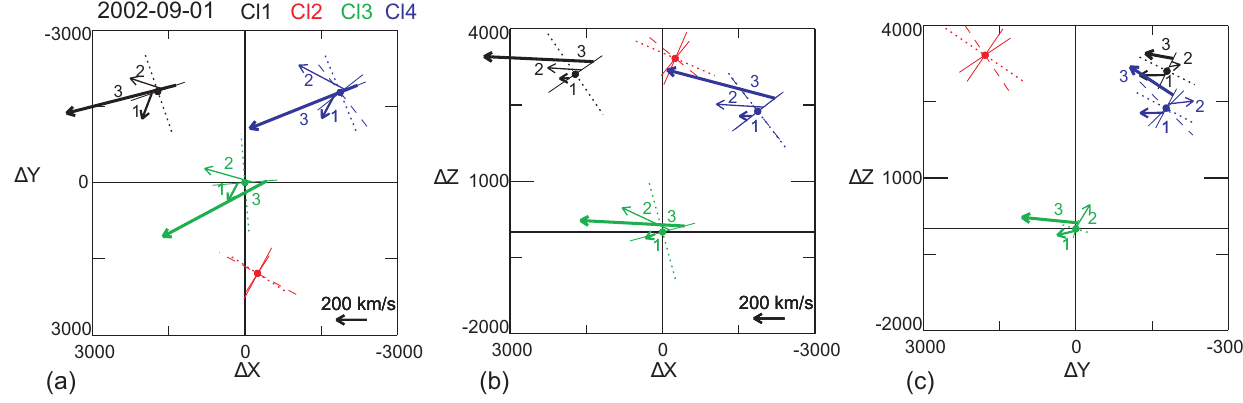
Fig. 5. The direction of the dipolarization front for the four spacecraft plotted as the projection in ( a ) the X − Y plane, in ( b ) the X − Z plane and in ( c ) the Y − Z plane together with the flow vectors for selected sequences from Clusters 1, 3, and 4. Dotted lines are the orientation obtained from the minimum variance analysis of the magnetic field and as dashed lines for the orientation obtained from the maximum variance analysis obtained from the electric field. The normal direction to the front is presented with a thin line crossing the dotted or dashed line. For each spacecraft the longest arrow marked with 3 corresponds to the maximum flow during the BBF event. The thin arrow drawn from an earthward proceeding point along the normal direction, corresponds to the flow vector at the time of the minimum angle after the dipolarization front and is marked with 2. The short thick arrow, marked with 1, drawn from a point further earthward along the normal direction, corresponds to the flow vector at the time of the first maximum deflection before the dipolarization front. Clusters 1, 2, 3 and 4 data are indicated with black, red, green, and blue,